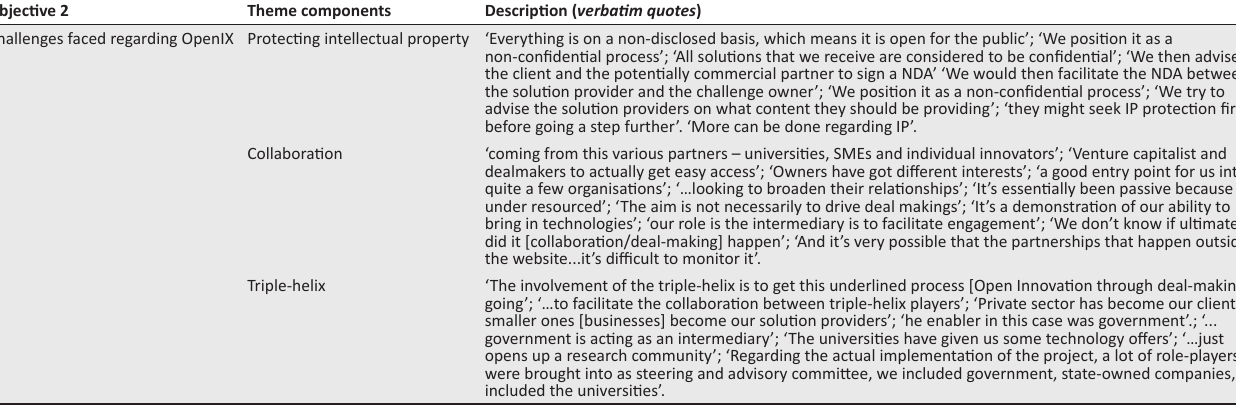
TABLE 2: Direct quotations of responses regarding the challenges faced when commercialising ideas the open innovation. Objective